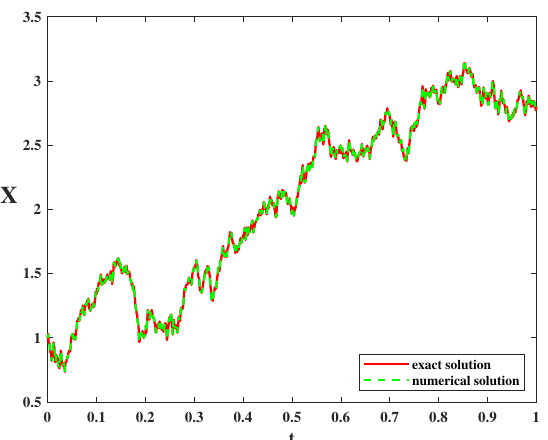
Figure 12. Comparison of exact solution and numerical solution in special case